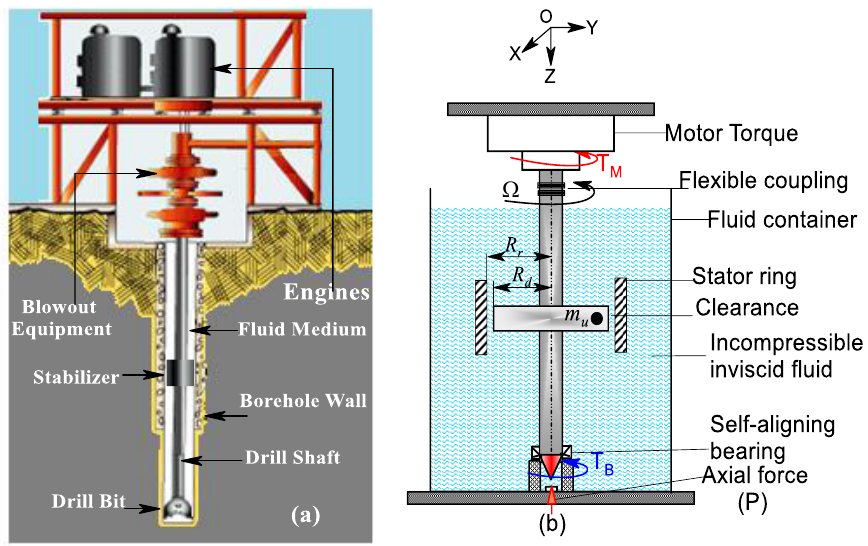
Figure 1. Typical rotary drilling rig. ( a ) Drill string model. ( b ) Simplified schematic model of the drill string.